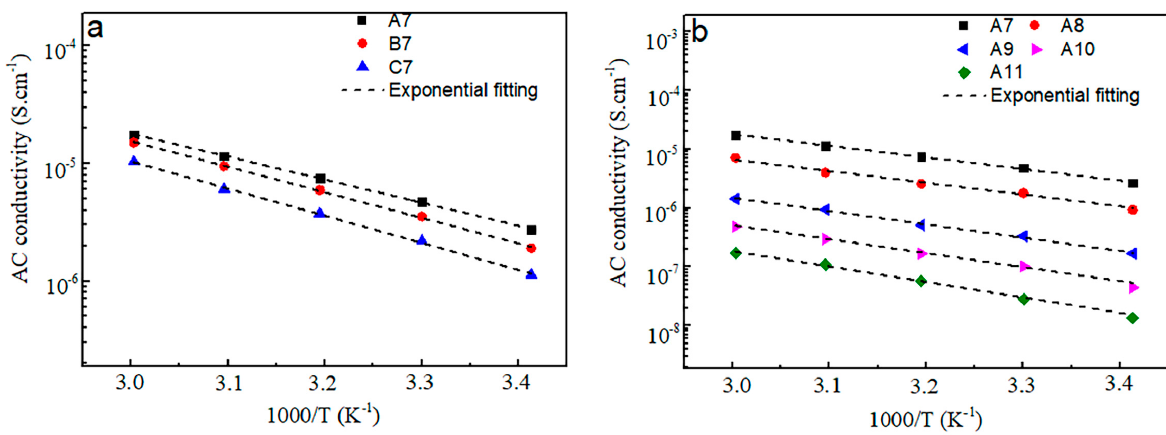
Figure 10. Temperature dependence on the AC electrical conductivities of GAST glasses: ( a )